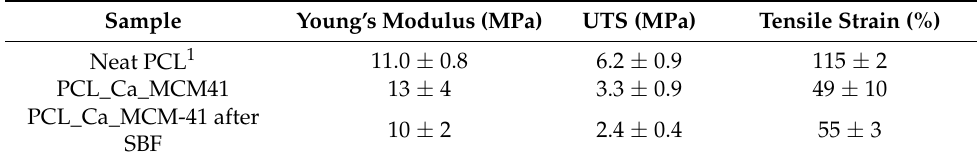
Table 1. Mechanical properties of the neat PCL and PCL composite electrospun fibers.